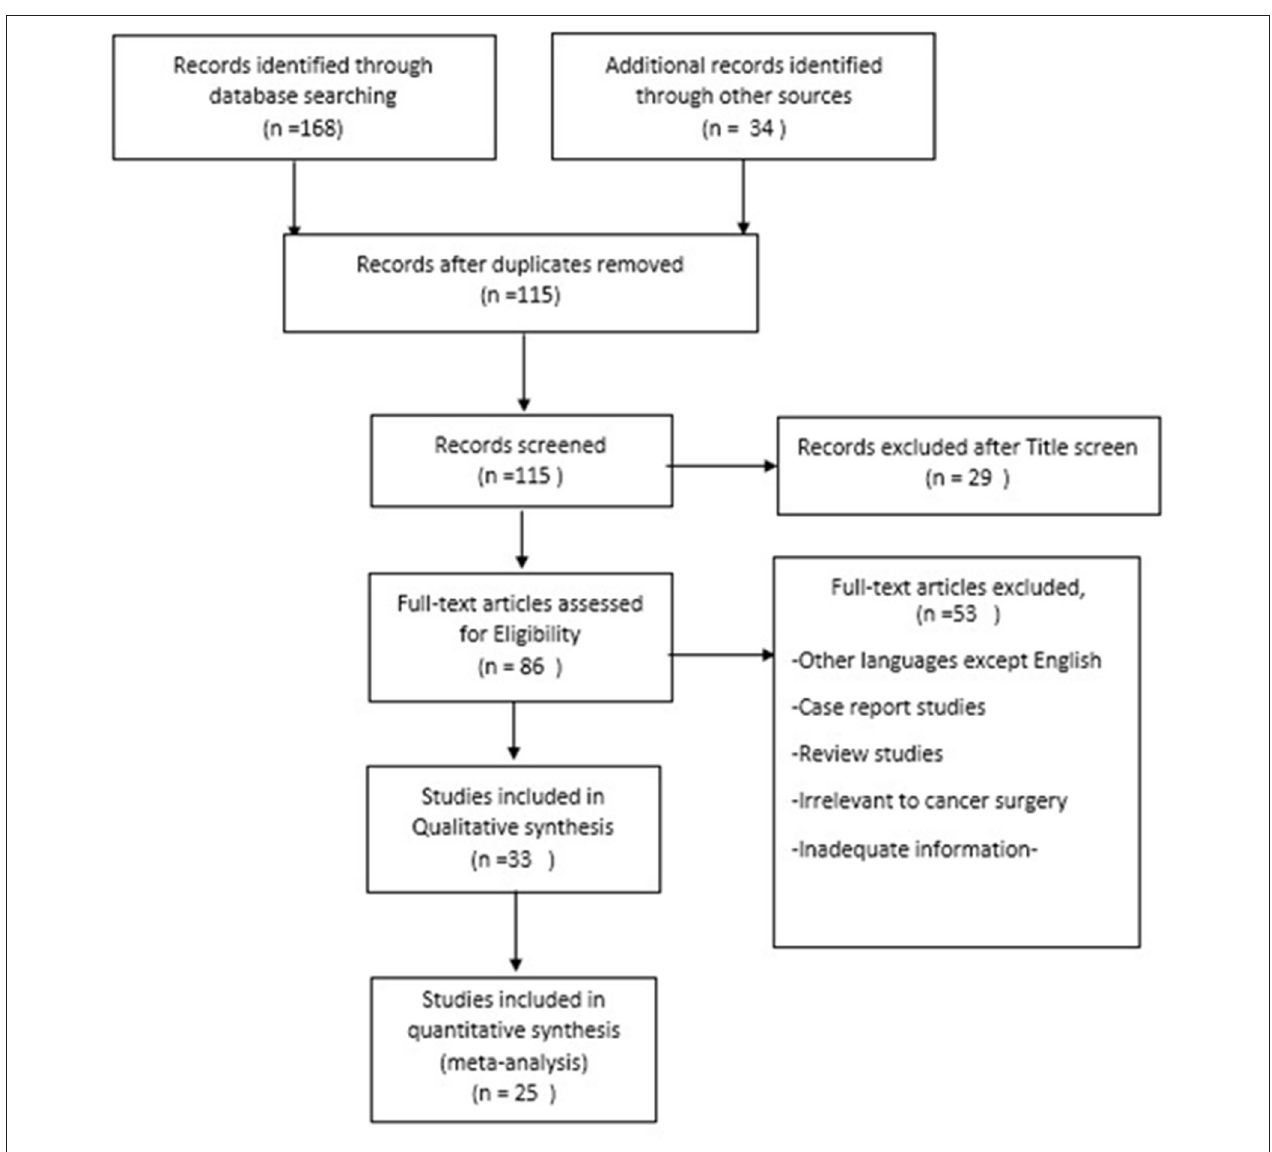
FIGURE 1 | Prisma flowchart of the